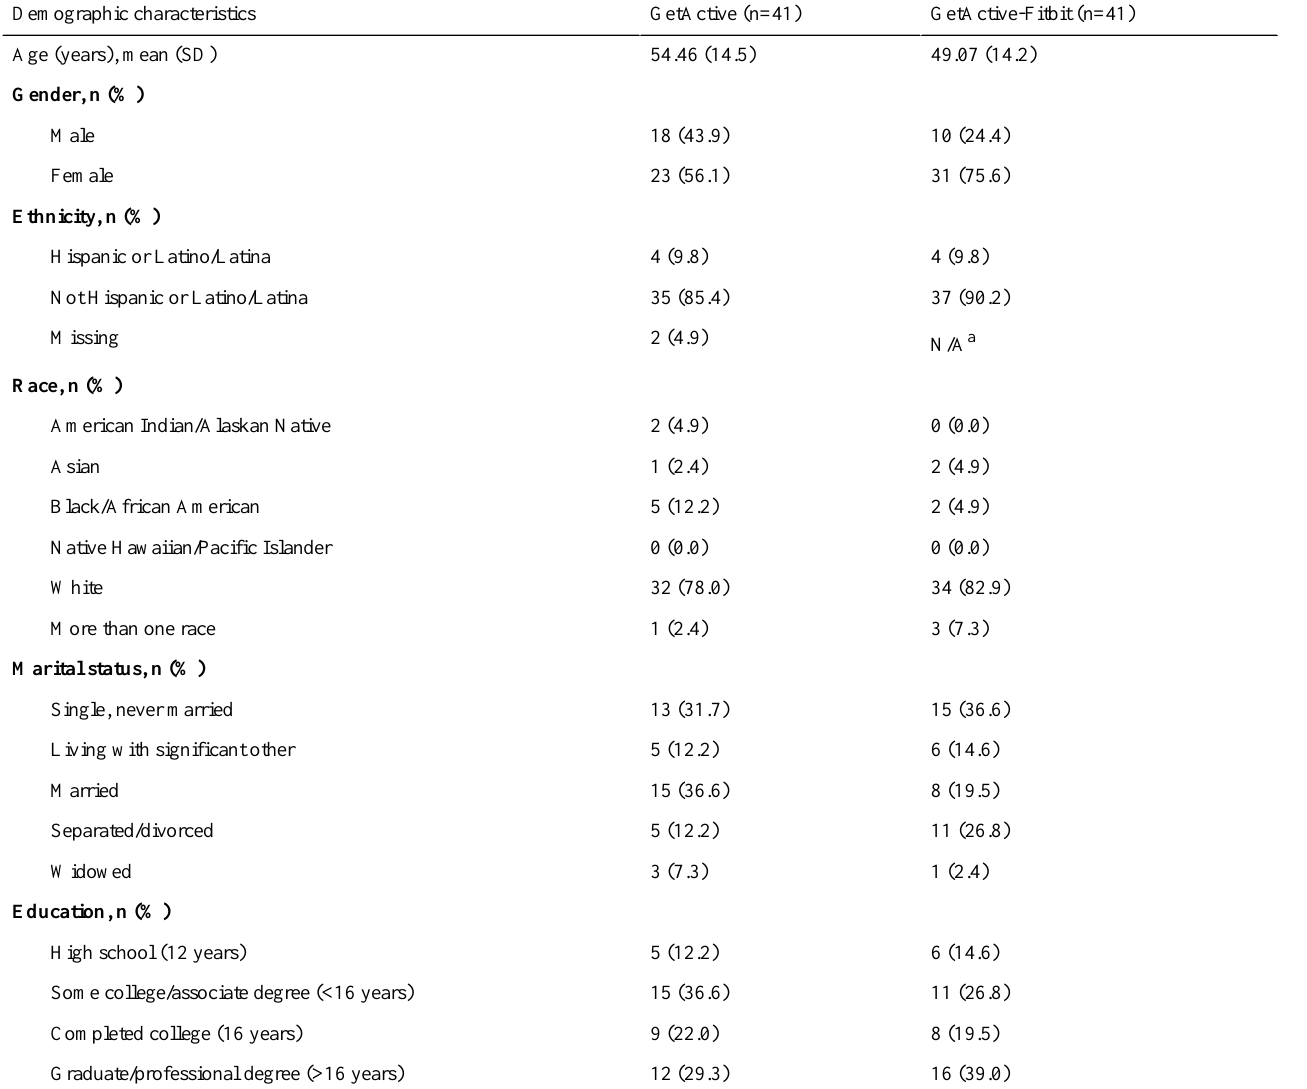
Table 1. Demographic characteristics of